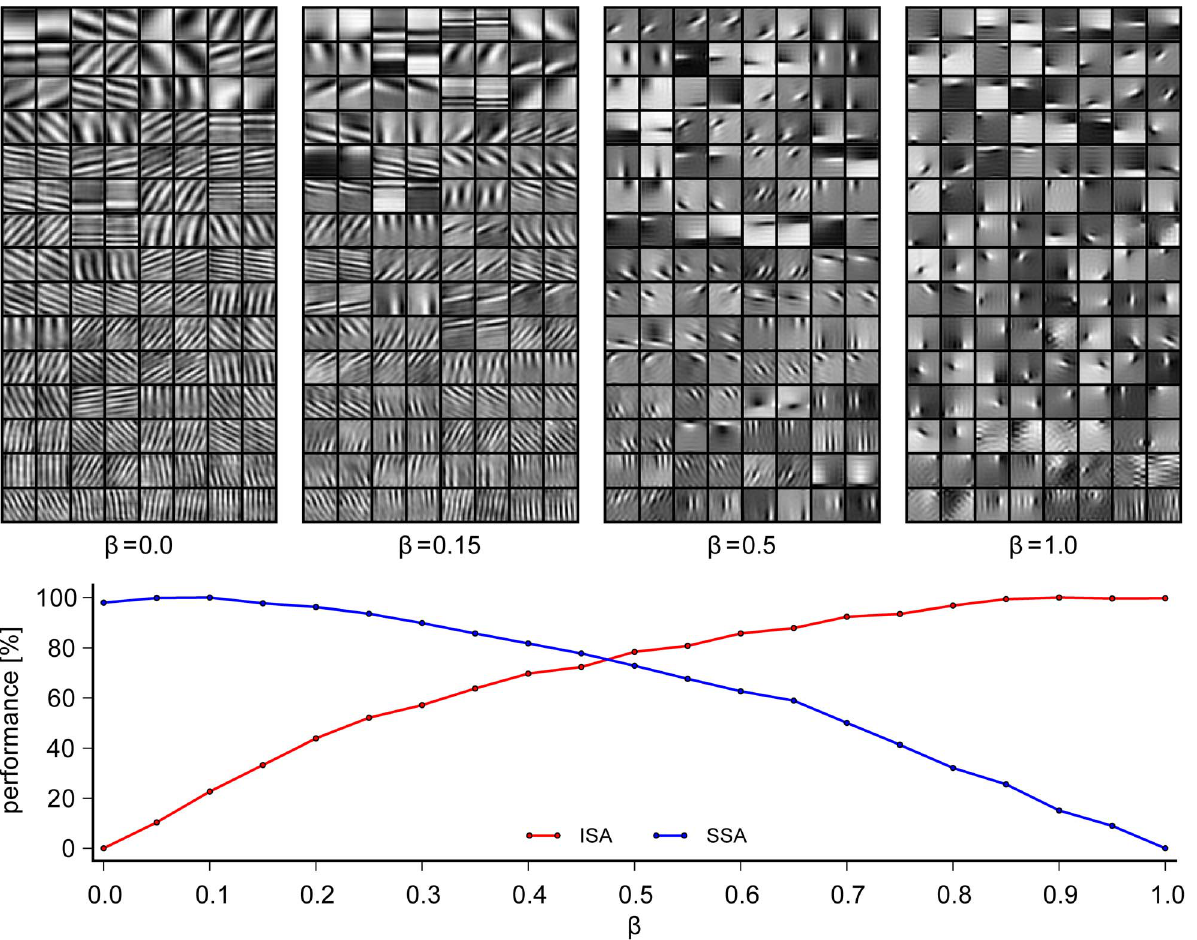
Figure 5. Filters of slowness, independence and mixture objective learned on movies. The lower panel shows the performance with respect to both the slowness objective E slow (blue) and the sparsity objective E sparse (red) and the upper panel displays four sets of filters as obtained for different values for the trade-off parameter b : The leftmost case ( b ~ 0 ) is equivalent to SSA and the rightmost case ( b ~ 1 ) is equivalent to ISA. There is a large difference between the two that can easily be grasped by eye. The example for b ~ 0 : 5 reflects the crossing point in performance (see lower panel) meaning that the representation performs slightly better than 80% of its maximal performance with respect to both objectives simultaneously. The case b ~ 0 : 15 was hand-picked to represent the point where the filters perceptually look similarly close to ISA and SSA.